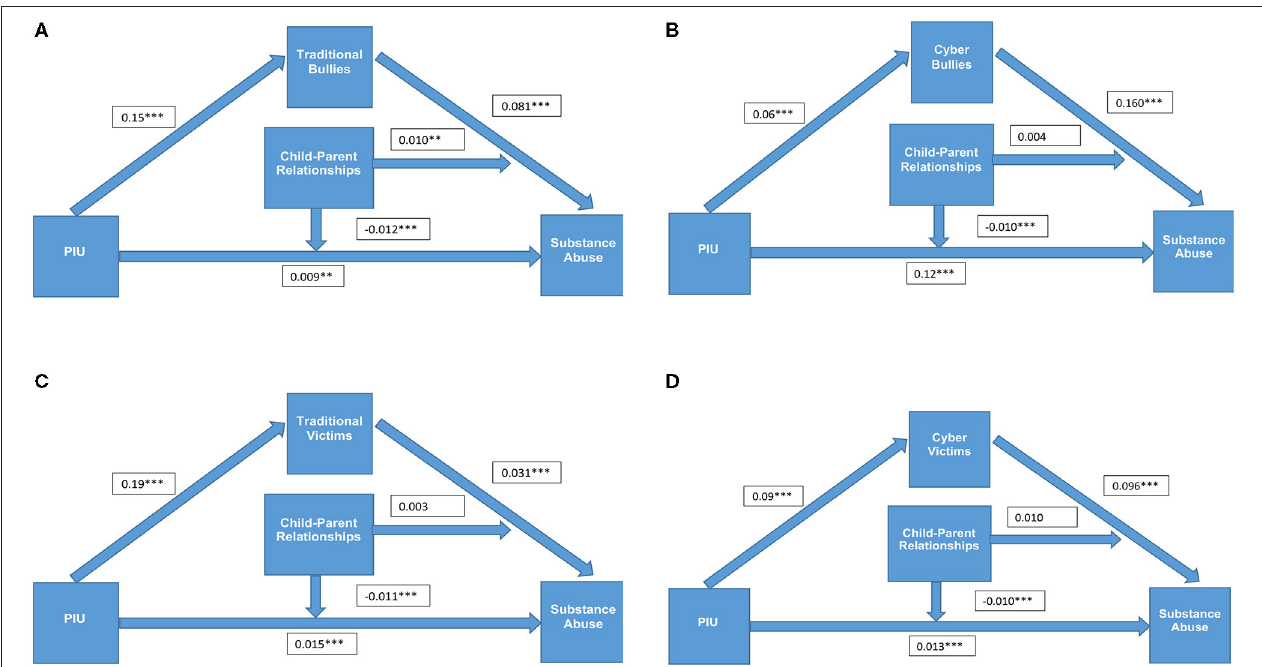
FIGURE 2 | (A) The moderated mediation model when traditional bullies is the mediator. (B) The moderated mediation model when cyber bullies is the mediator. (C) The moderated mediation model when traditional victims is the mediator. (D) The moderated mediation model when cyber victims is the mediator. ** P < 0.01; *** P <